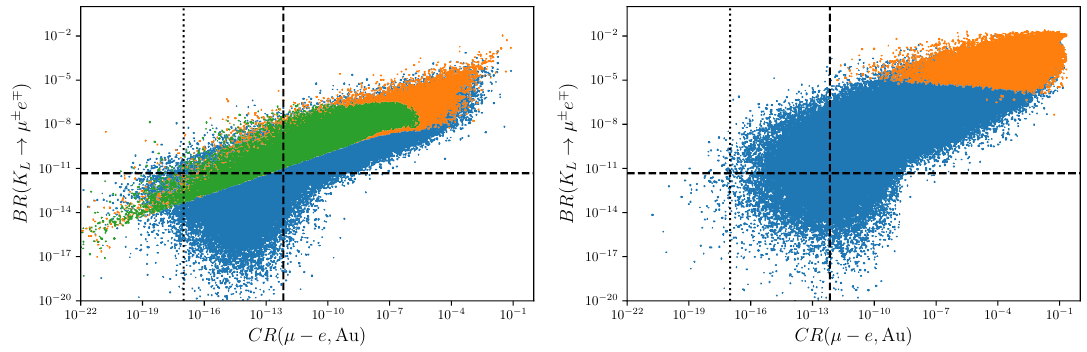
Figure 5 . Regions in the plane spanned by CR( (cid:22) (cid:0) e ,N) and BR( K L ! (cid:22) (cid:6) e (cid:7) ), accommodating R (left panel) and R (right panel), respectively for leptoquark masses in the intervals m V 2 K ( (cid:3) ) D ( (cid:3) ) [15 TeV ; 45 TeV] and m V 2 [1 TeV ; 6 TeV], in the framework of nonunitary leptoquark couplings induced by the presence of 3 generations of isosinglet heavy leptons . Blue points satisfy R at the 3 (cid:27) level, yellow points are consistent with leptonic Z decays, and green points are compatible with all imposed constraints, other than those depicted by the corresponding vertical and horizontal dashed lines (dotted ones denoting future sensitivities). In both panels, all mixing angles have been varied randomly between (cid:0) (cid:25) and (cid:25)